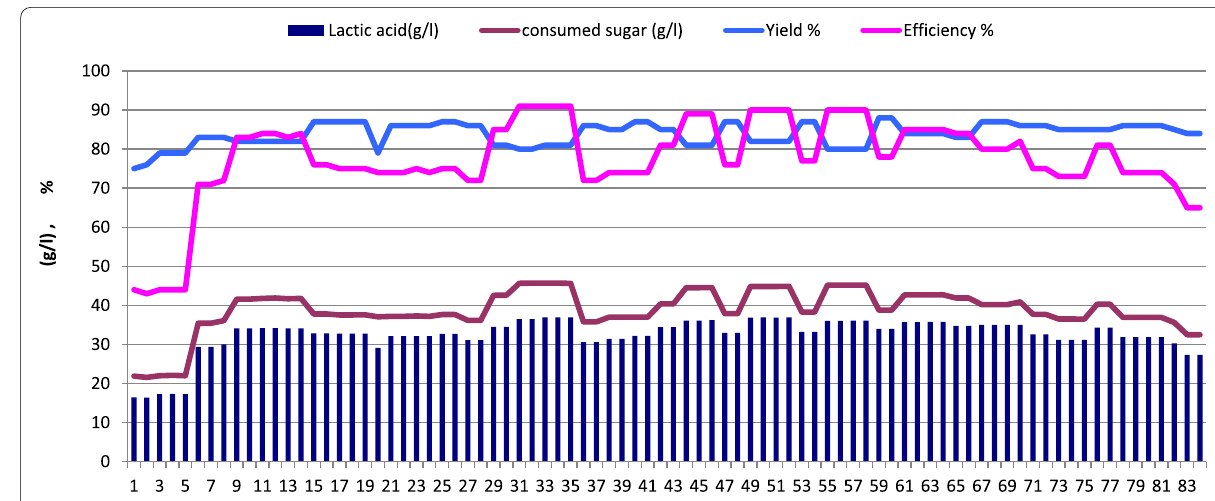
Fig. 4 Lactic acid production from salted cheese whey and whey permeate mixture (1:1, contained 5% sugar) using immobilized cells of Enterococcus faecalis